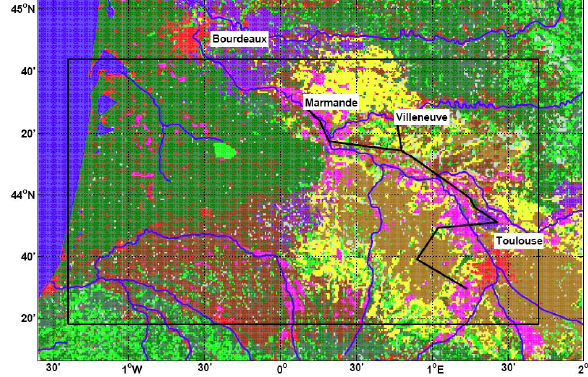
Fig. 1. Enhanced 1-km resolution CORINE2000 land-use map of south-west of France and schematic river system with experimental domain of CERES’07 measurement campaign (box) with our two schematic flight tracks for both